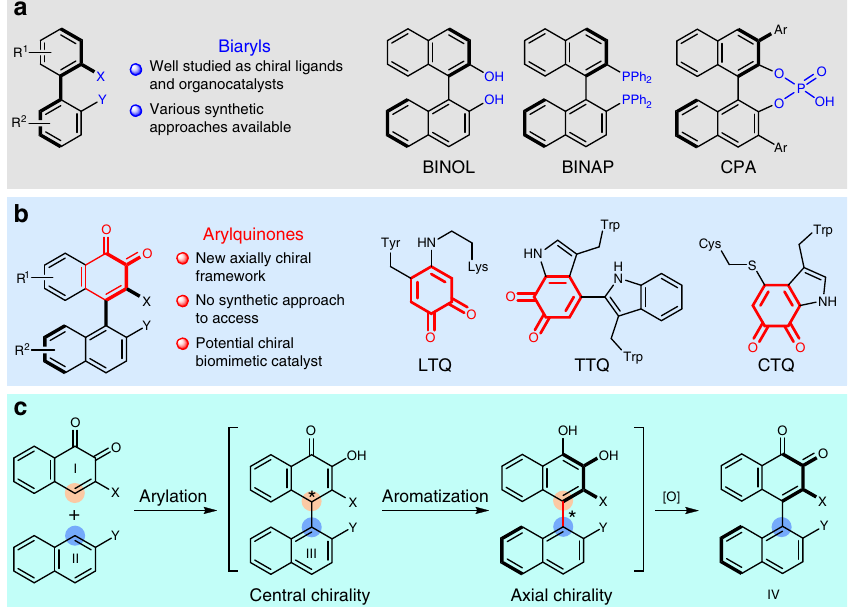
Fig. 1 Axially chiral biaryls vs. axially chiral arylquinones and their synthesis. a Biaryls as chiral ligands and organocatalysts. b o -Quinone structures in biomimetic catalysts. c Our designed approach to access arylquinone